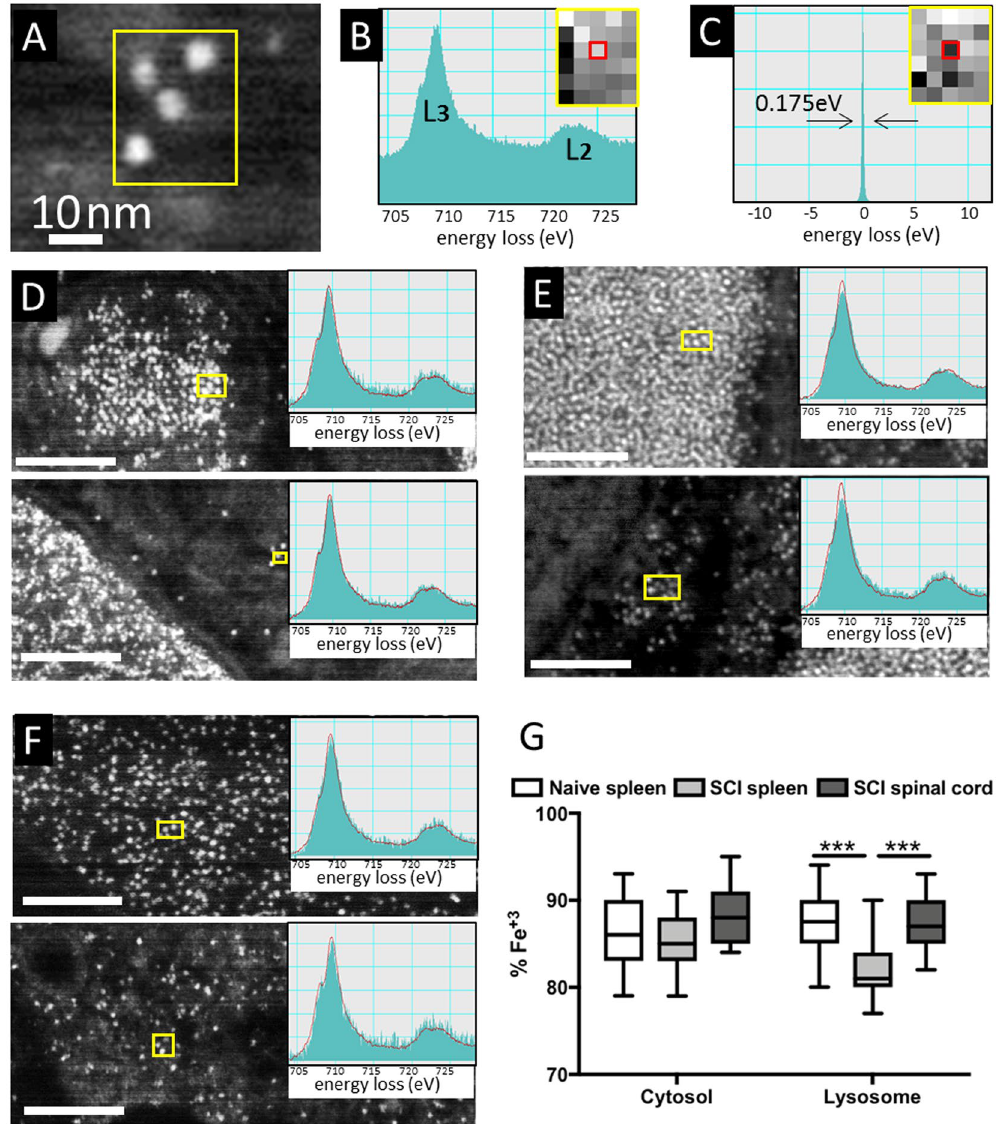
Figure 6. In situ EELS characterization of oxidation state of ferritin(iron) in the cytoplasm and lysosomes of macrophages. ( A ) STEM image of ferritin(iron) in naïve spleen. Corresponding high and low energy loss images of the same region are shown as insets in ( B ) and ( C ) respectively. ( B ) Spectrum showing Fe L 2,3 edge from a selected pixel (red) in the high energy loss image. ( C ) Spectrum showing the zero-loss peak with energy resolution of 0.175 eV from a selected pixel (red) in the low energy loss image. ( D – F ) STEM image (inset: EELS spectra from a pixel in the selected region) from the lysosomes (top) and cytoplasm (bottom) of ( D ) naive spleen, ( E ) SCI spleen and ( F ) SCI spinal cord; scale bar: 100 nm. ( G ) Box plots showing percentage of Fe 3 + in individual ferritin cores in the lysosome ( L ) and cytoplasm ( C ) of various samples as indicated. ‘ *** ’ Indicates p-value <